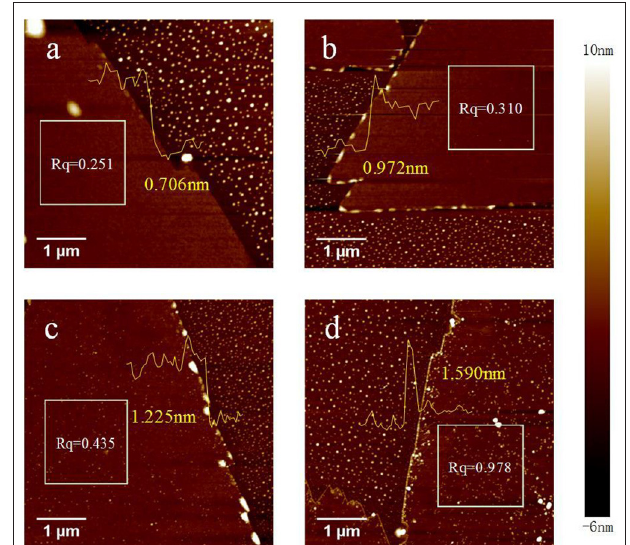
before and after baking at different temperatures for 2h under air. (A) The original monolayer MoS 2 film prepared by the chemical vapor deposition method. The monolayer MoS 2 film baked at (B) 150 ◦ C, (C) 200 ◦ C, and (D) 250 ◦ C. The yellow line indicates the surface height of the monolayer MoS 2 film. The area indicated with the white square was measured to confirm the roughness. Scale bar, 1 µ